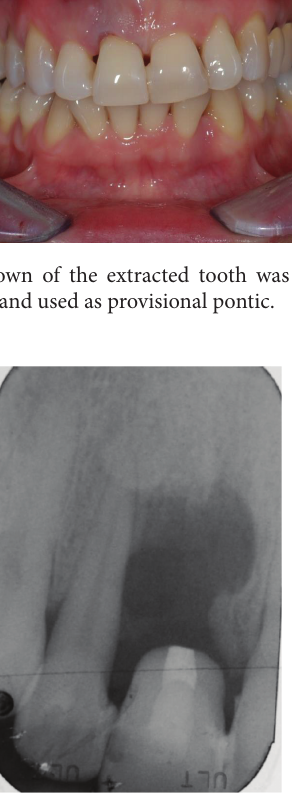
Figure 6: Postoperative X-ray after tooth extraction.